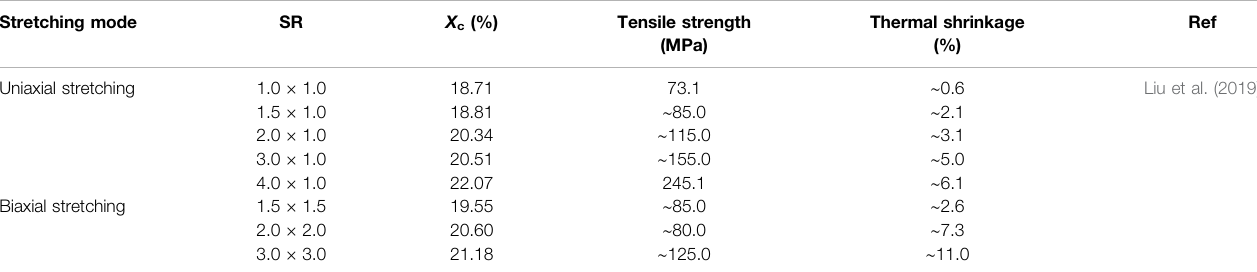
TABLE 2 | The relative crystallinity ( X c ), tensile strength, and thermal shrinkage of uniaxially and biaxially stretched PA6-66-MMT-nanosilica composites. Stretching